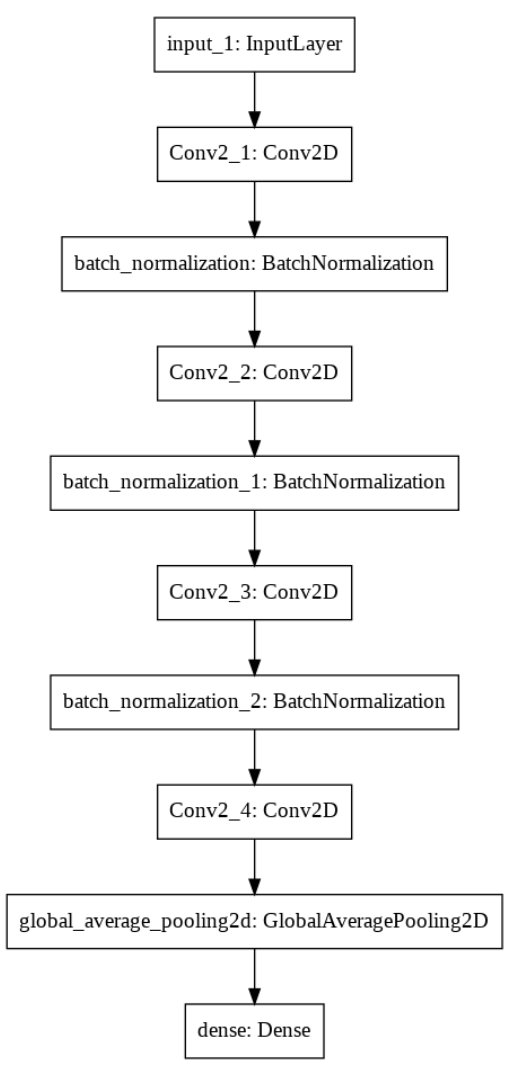
Figure 5. Convolutional neural network model.